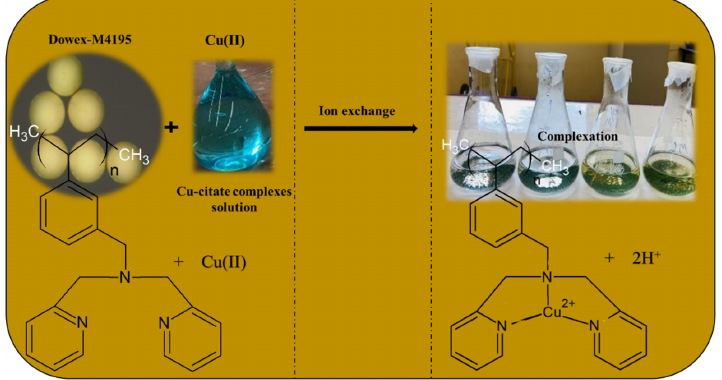
Figure 5. SEM-EDX image of Cu(II) loaded onto H + Dowex-M4195 chelating resin.